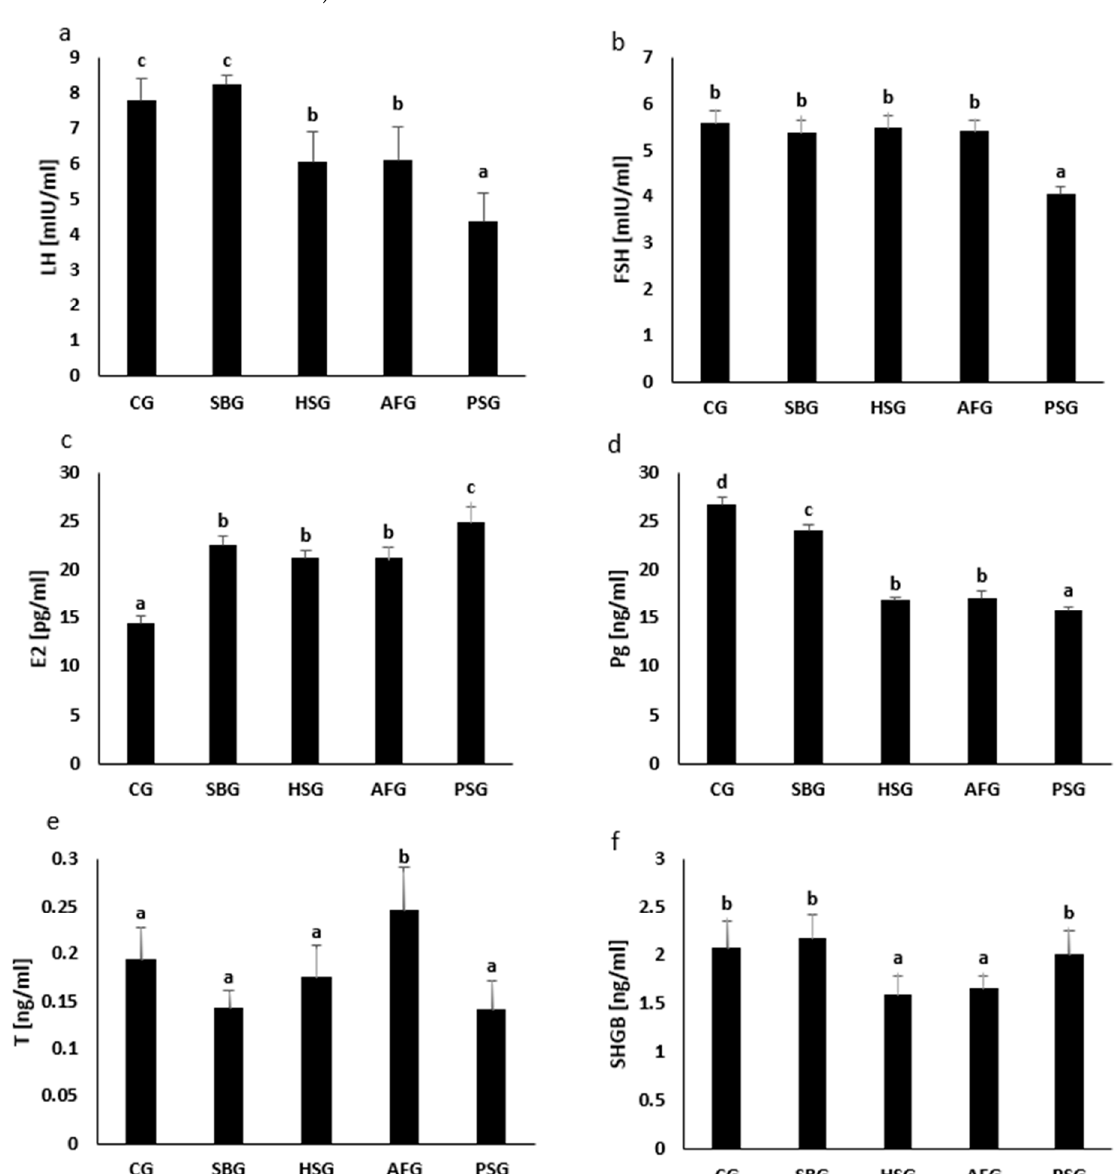
Figure 1. Effects of various sucrose-containing diets and feeding patterns on the serum concentrations of ( a ) luteinizing hormone (LH), ( b ) follicle-stimulating hormone (FSH), ( c ) estradiol (E2), ( d ) progesterone (Pg), ( e ) testosterone (T), and ( f ) sex hormone-binding globulin (SGBG) in female rats. CG, control group; SBG, sugar-balanced group; HSG, high-sugar group; AFG, alternately feeding group; PSG, periodically starved group; a, b, c, and d, bars marked with different letters reflect significantly different ( p ≤ 0.05) outcomes; Tukey test, p -values are given in Table S8; n = 50 (10 per each group).